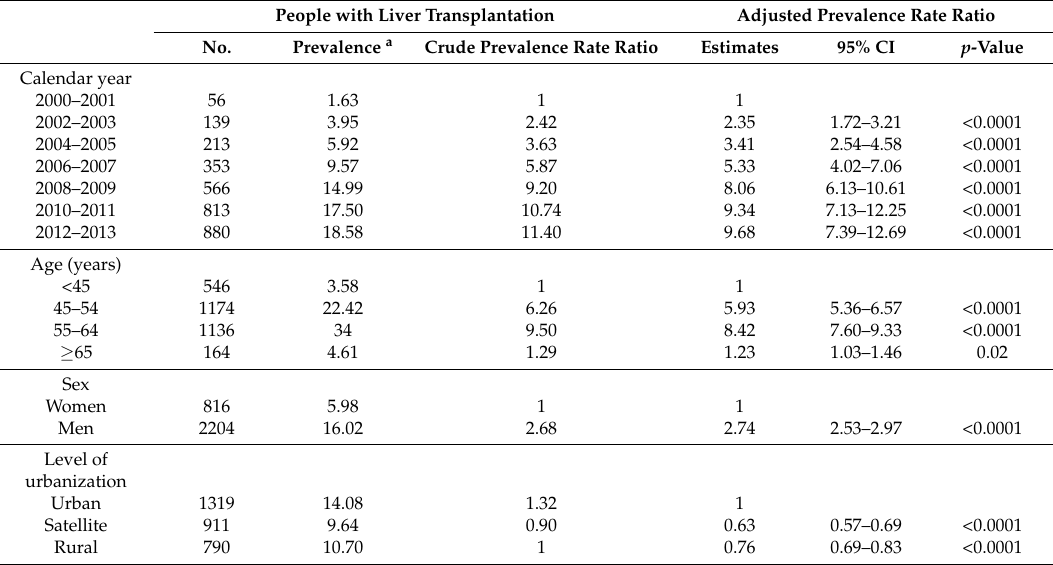
Table 3. Associations of calendar year, demographics, and urbanization with rate of liver transplantation. People with Liver Transplantation Adjusted Prevalence Rate Ratio No. Prevalence a Crude Prevalence Rate Ratio Estimates 95% CI p